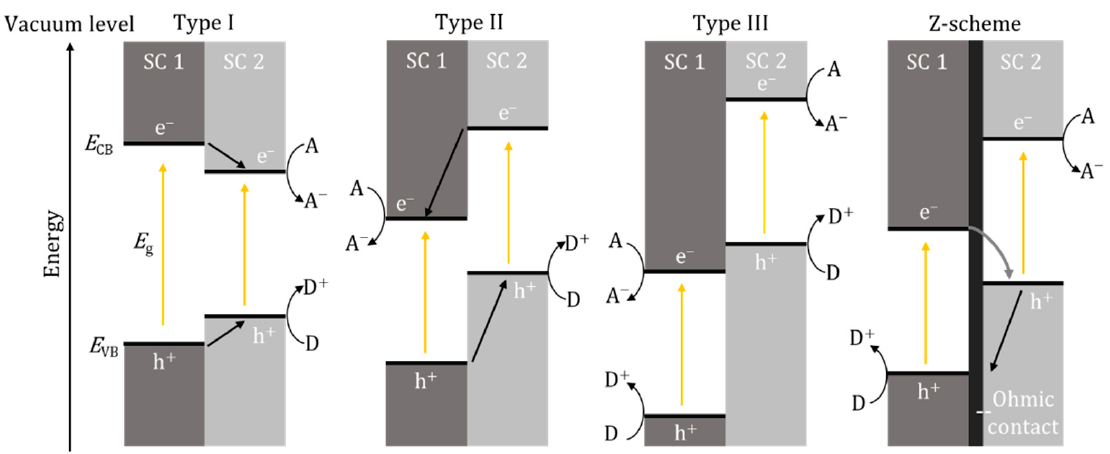
Figure 6. Band edge positions and electron/hole movement for type I, II and III heterostructures and z-scheme. SC—semiconductor, A—electron acceptor, D—electron donor, e − —electron, h + — hole.